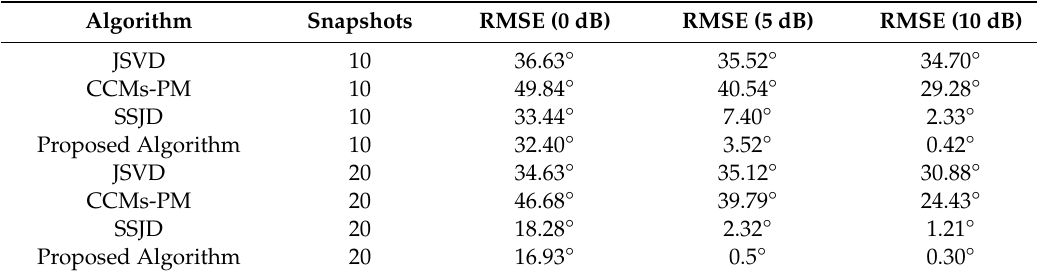
Table 2. Comparison of estimation RMSE for di ff erent